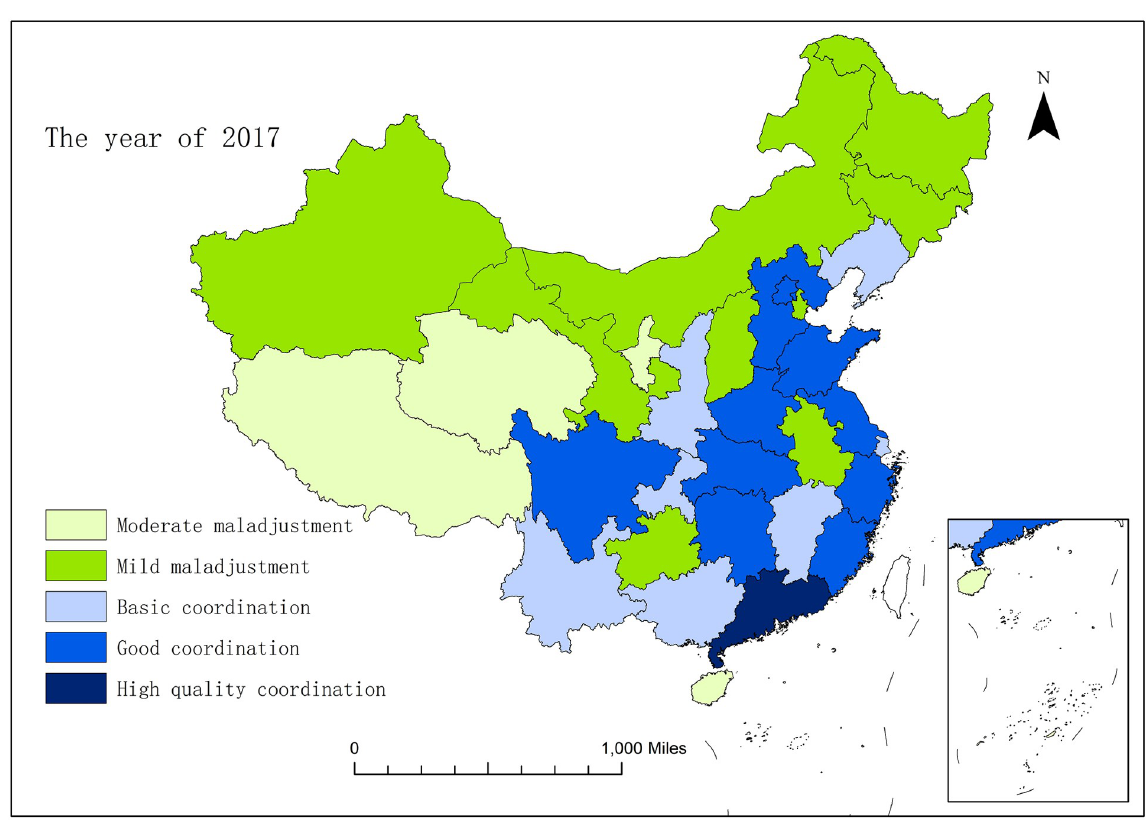
Fig 5. The spatial pattern of coupling and coordination of the sports industry and health service industry in 31 provinces and cities of China in the year of 2017.